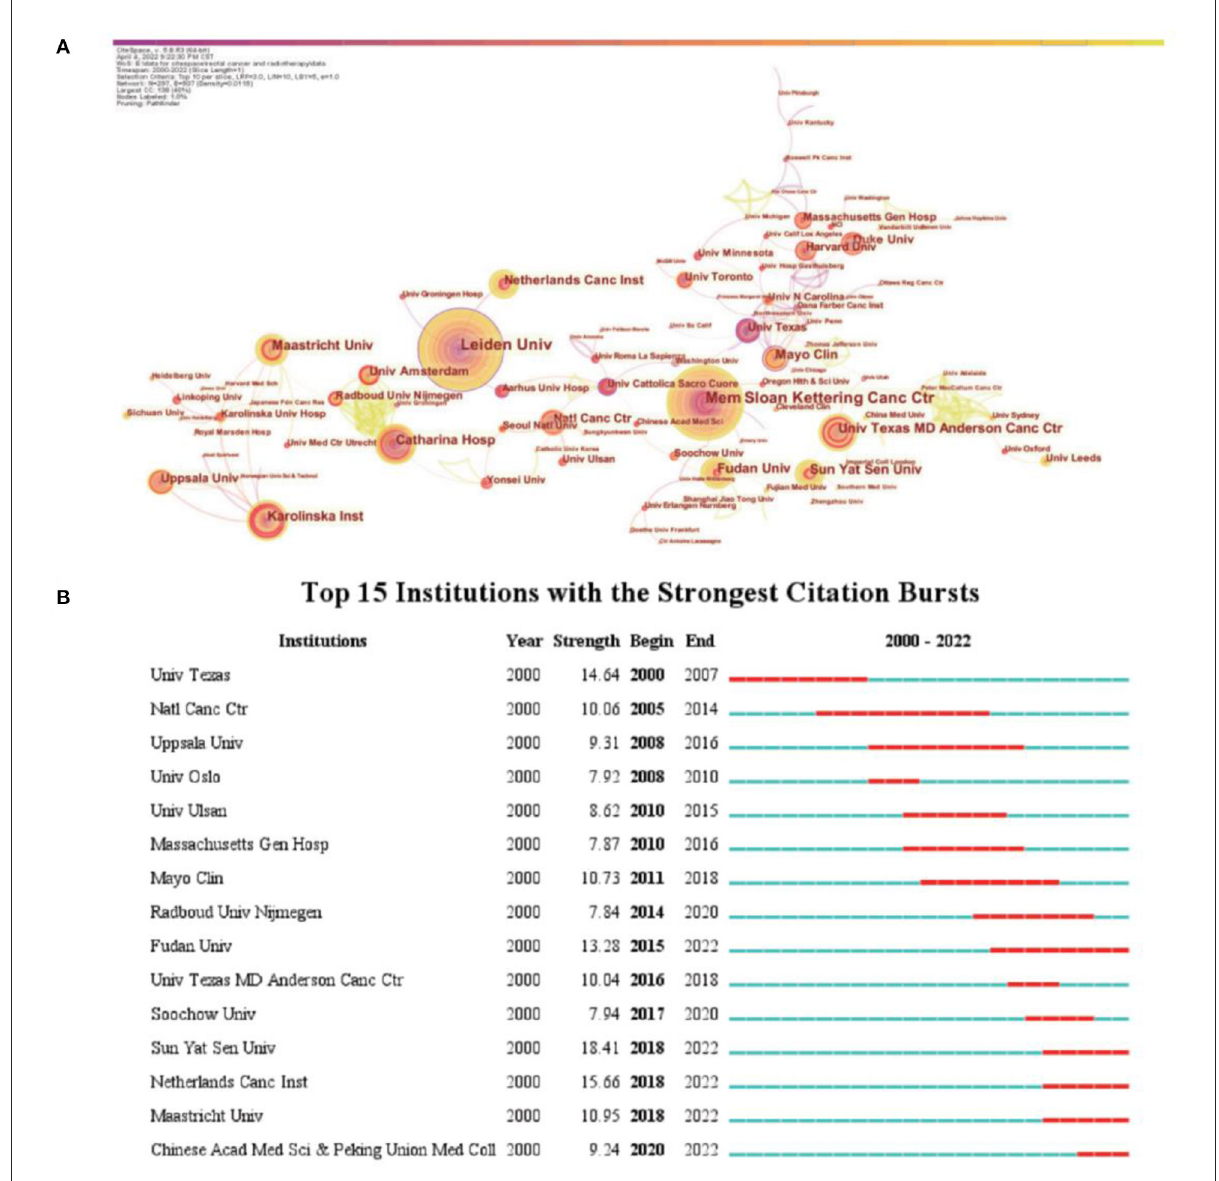
FIGURE3 Analysis of institutions involved in research on radiotherapy for rectal cancer. (A) Network diagram showing institution links (Timespan: 2000–2022; Slice Length: 1; Selection Criteria: Top10 per slice; Network: N = 297, E = 507; Density: 0.0115; Largest CC:138; Nodes Labeled:1.0%; Pruning: Pathfinder). (B) Top 15 institutions in publishing research related to radiation therapy for rectal cancer with burst period after